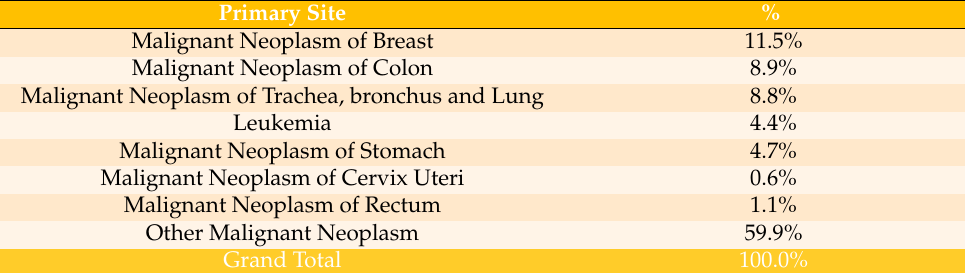
Table 3. Distribution of malignant cancer deaths by type of cancer in UAE,